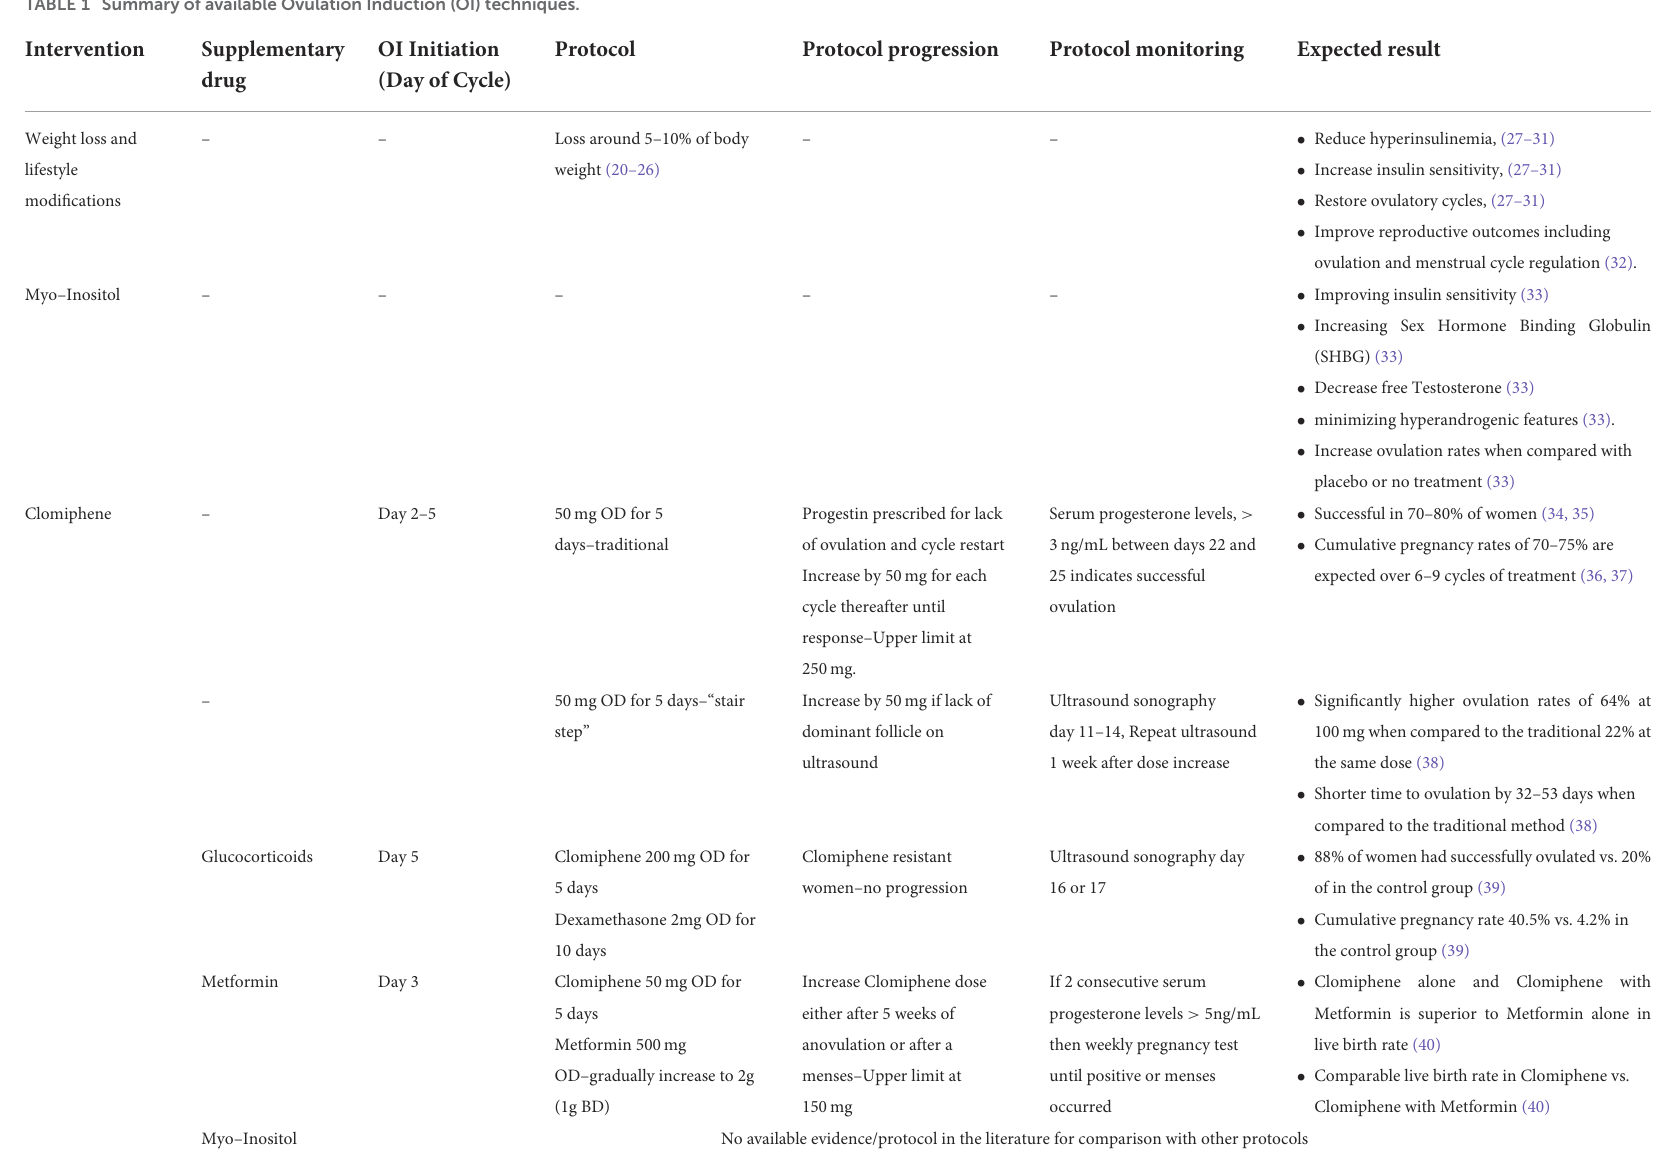
TABLE 1 Summary of available Ovulation Induction (OI)